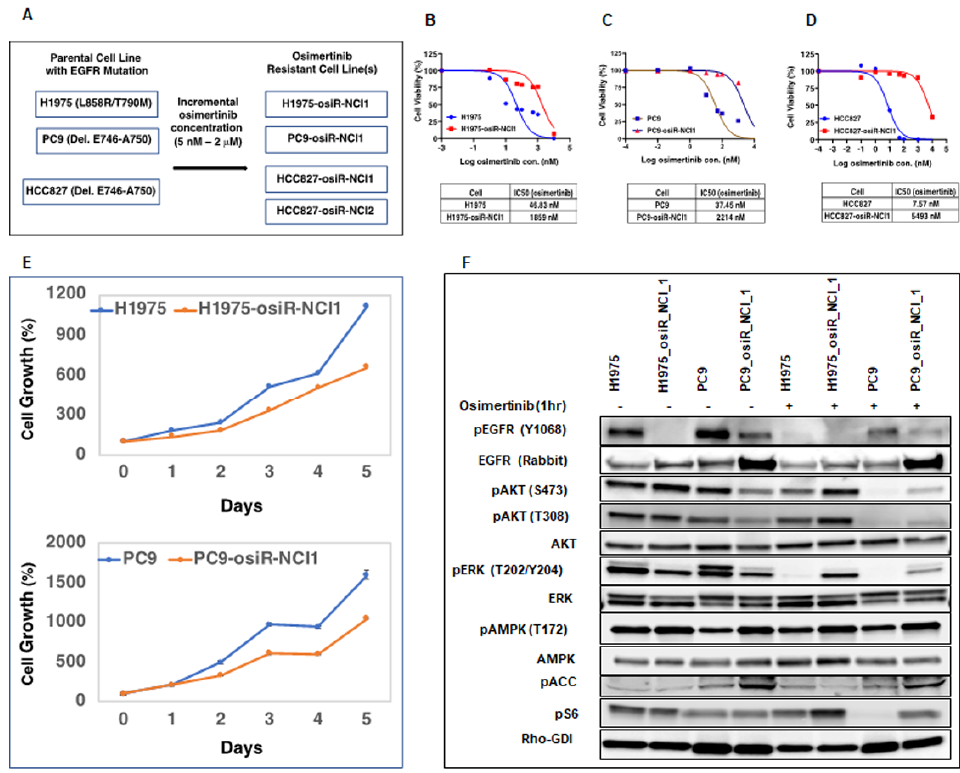
Figure 1. Generation of osimertinib-resistant lung adenocarcinoma cell lines. ( A ). Osimertinib-resistant isogenic H1975-osiR-NCI1, PC9-osiR-NCI1, HCC627-osiR-NCI1, and HCC627-osiR-NCI2 cell lines were generated from osimertinib-sensitive H1975, PC9, and HCC827 cells by osimertinib dose escalation. ( B – D ). Cell-growth-inhibition end-point assays were performed by growing osimertinib-sensitive and -resistant cells in drug-free medium for 3 days prior to transferring to medium containing serial dilutions of osimertinib. IC50s indicate that osimertinib-resistant cells have significantly higher drug tolerance (1859 nM–5493 nM) than osimertinib-sensitive cells (7.57 nM–46.83 nM). ( E ). Five-day cell growth assay indicates that osimertinib-resistant cells have a slower growth rate than osimertinib-sensitive cells. ( F ). Osimertinib-sensitive and -resistant cells were grown in drug-free medium for 3 days prior to treatment with DMSO (control) or 50 nM osimertinib for 1 h. Cell lysates were immunoblotted with indicated antibodies. Rho-GDI antibody was used as a loading control.